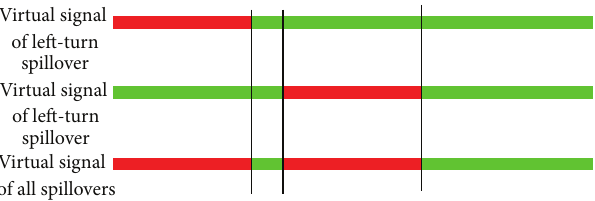
Figure 25: Virtual signal of both spillover.